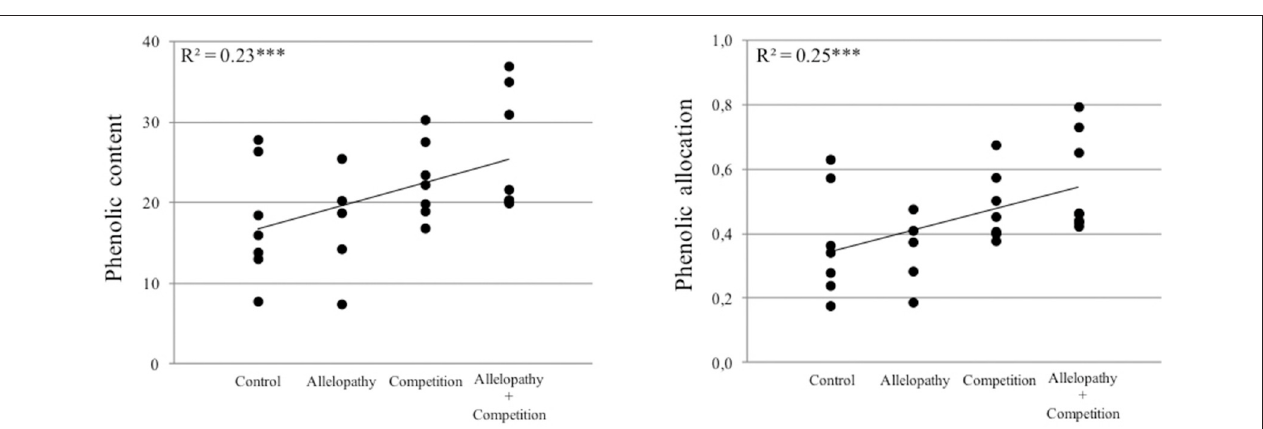
FIGURE 7 | Relationship between phenolic content or phenol allocation and the gradient of interference for both Pinus and Quercus species (Control, Allelopathy, Competition, Allelopathy +